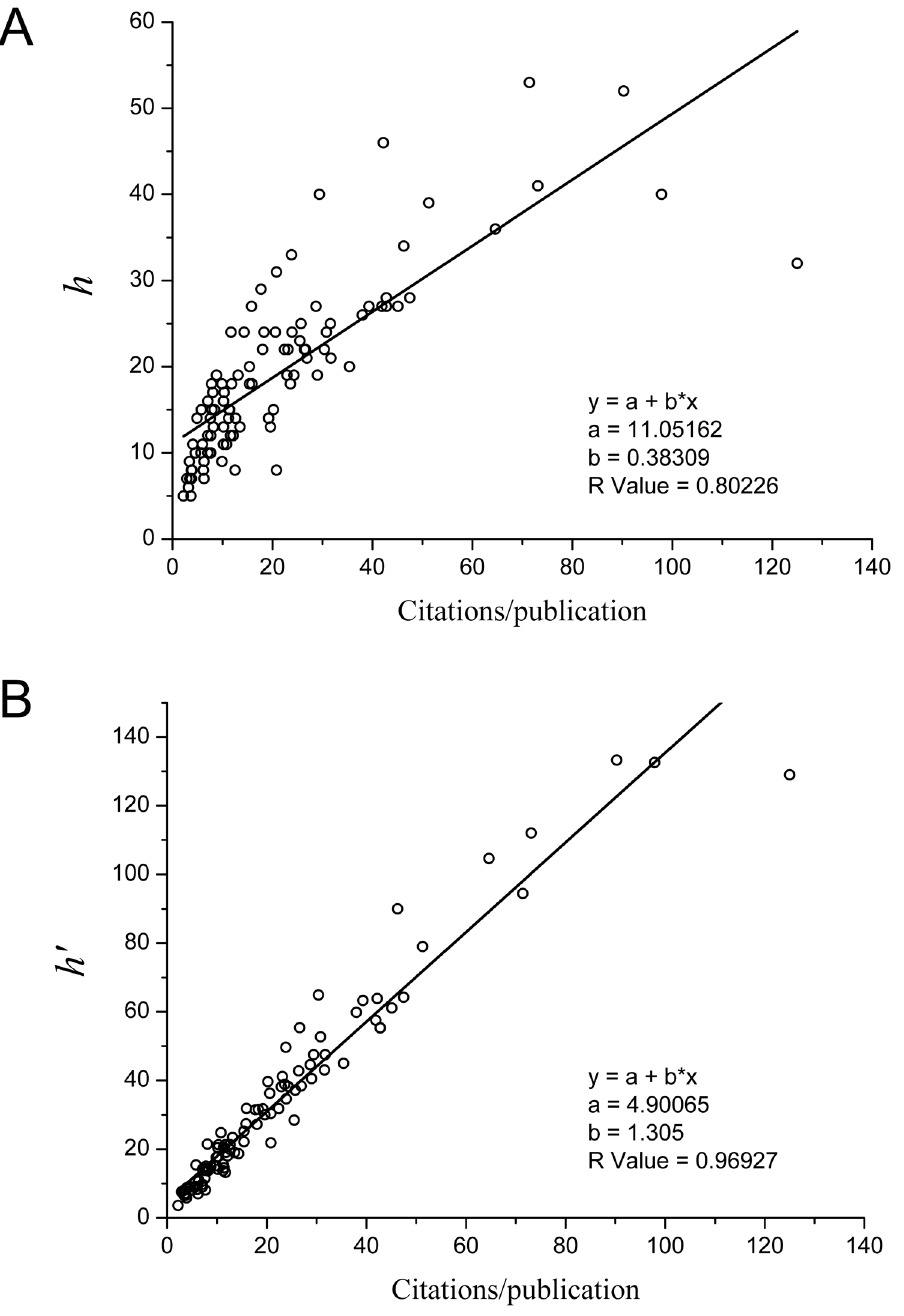
Figure 3. The correlation between the h- index and the h ’ -index with the index of the citations per publication. A, the correlation between the h- index and the index of the citations per publication, and B, the correlation between the h ’ -index and the number of total citations, based on the data of the 100 most prolific economists. Note that the h ’ -index shows better linear correlation with the index of citations per publication than the h-